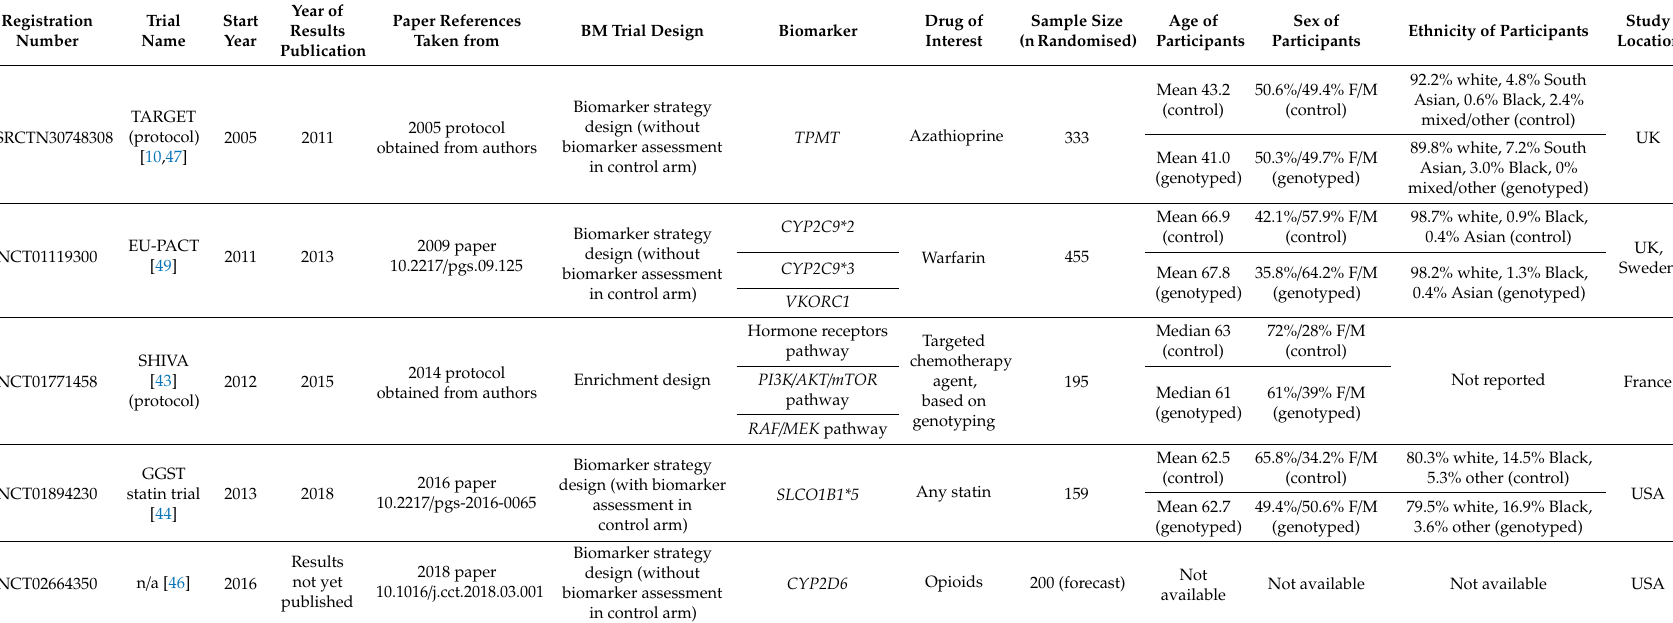
Table 1. Details of selected trials. Start year denotes year the first patient was recruited. BM trial (biomarker-guided trial) design is the design as selected by using the BiGTeD online resource